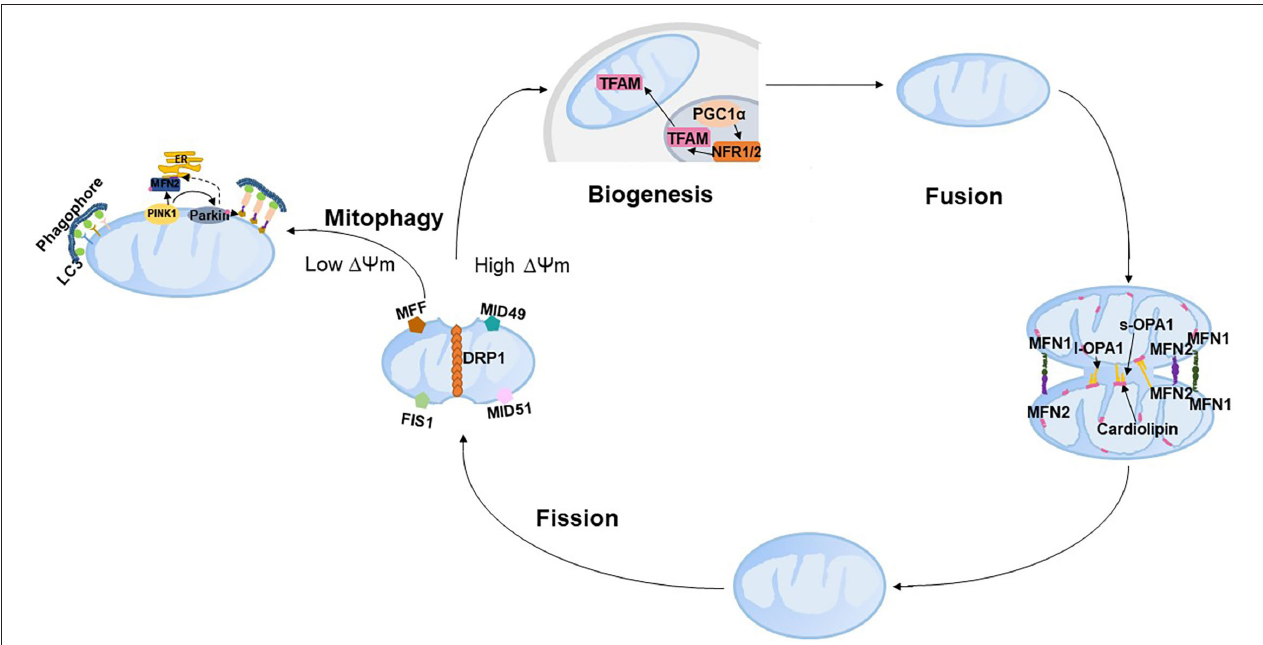
FIGURE 2 | Schematic representation of mitochondrial quality control. PINK, PTEN-induced putative kinase 1; LC3, microtubule-associated protein 1 light chain 3; ER, endoplasmic reticulum; DRP1, dynamin-related protein 1; FIS1, fission 1; MFF, mitochondrial fission factor; MID49, mitochondrial dynamics protein of 49 kDa; and MID51, mitochondrial dynamics protein of 51